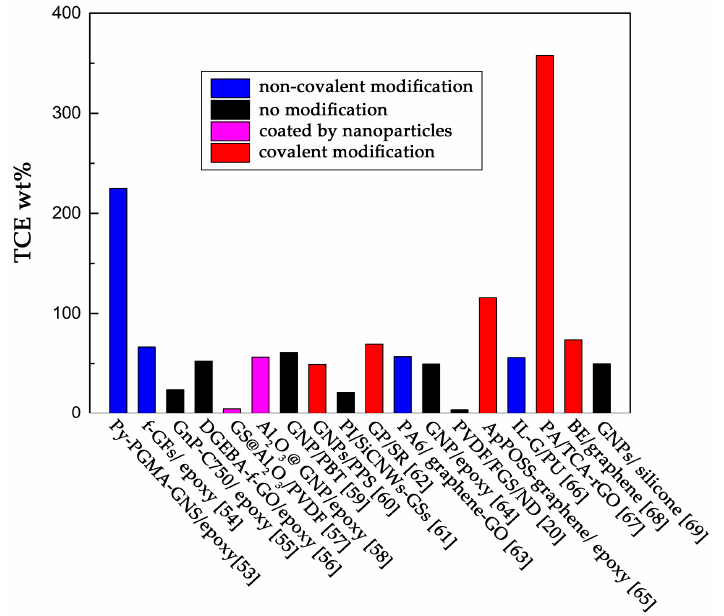
Figure 4. TCE wt % of composites in Table 1.